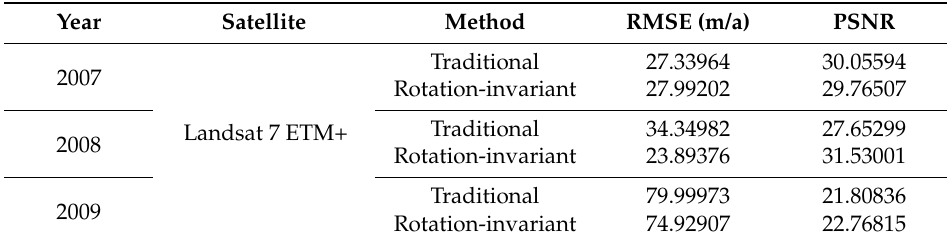
Table 3. The accuracies of the different methods compared with the MEaSUREs InSAR-based Antarctic ice velocity map (m/a) (Profile from C to